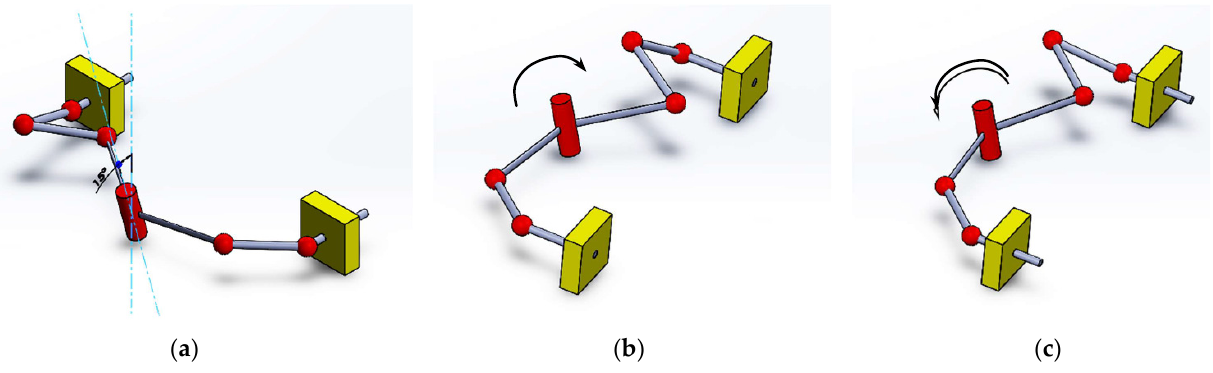
Figure 9. The proposed 1-DoF linkage mechanism in the general position ( a ), opened, ( b ) and closed configuration ( c ). Red color identifies the joints, the spheres indicate spherical joints, and the cylinder represents a rotational joint. Yellow elements represent portions of the drone fuselage.